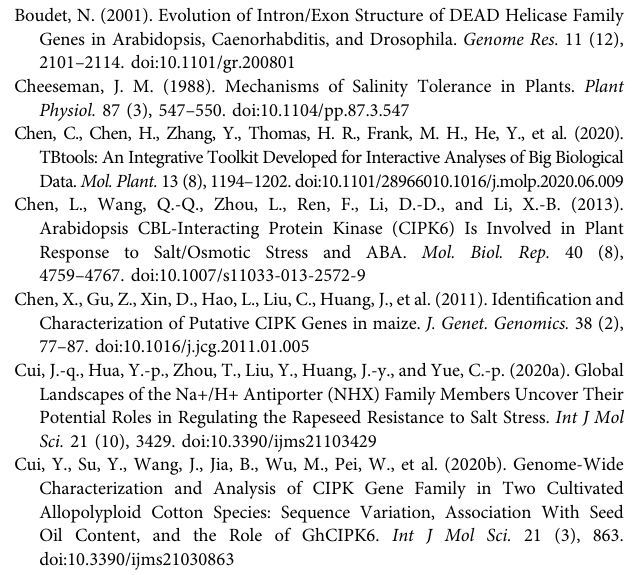
Supplementary Figure S1 | Details ofmotifs in LjCBL proteins identi fi ed byMEME. SupplementaryFigureS2| DetailsofmotifsinLjCIPKproteinsidenti fi edbyMEME. Supplementary Figure S3 | Details of the secondary structure of LjCBL proteins. Supplementary Figure S4 | Details of the secondary structure of LjCIPK proteins. Supplementary Table S1 | Phylogeny sequences. Primer sequence. Pairwise sequence similarity and divergence. The non-synonymous/synonymous (Ka/Ks) ratio. Motif